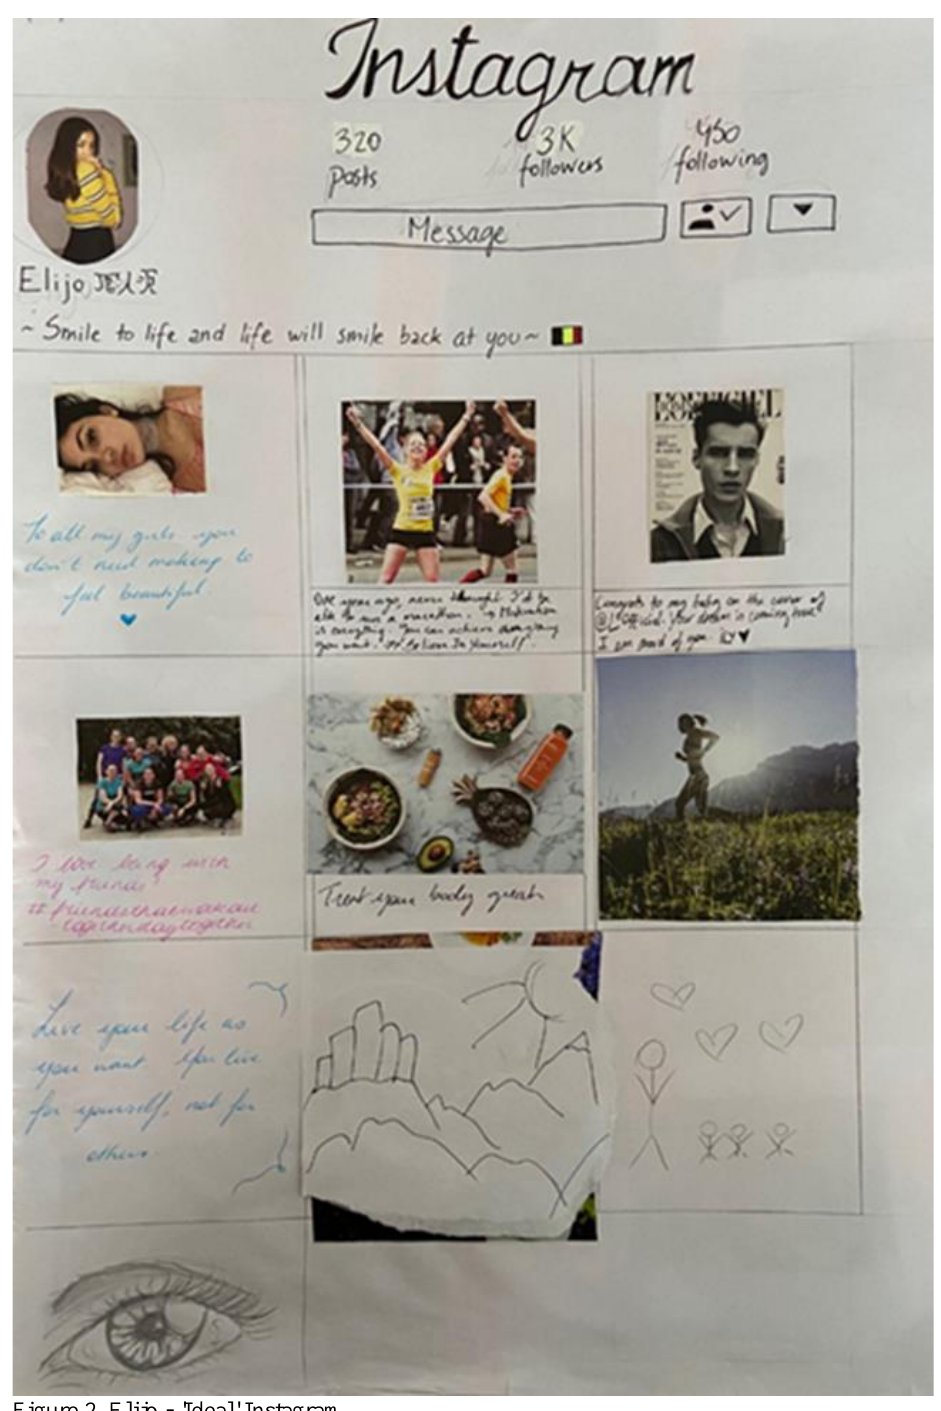
Figure 2. Elijo - 'Ideal' Instagram Gendered